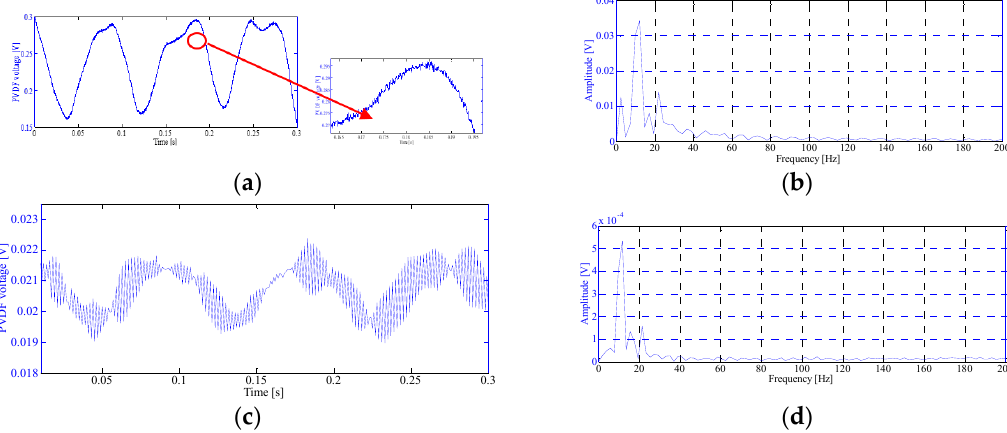
Figure 13. Diagrams of ( a ) experimental results; ( c ) simulation results. Frequency analysis diagrams of ( b ) experimental results; ( d ) simulation results.